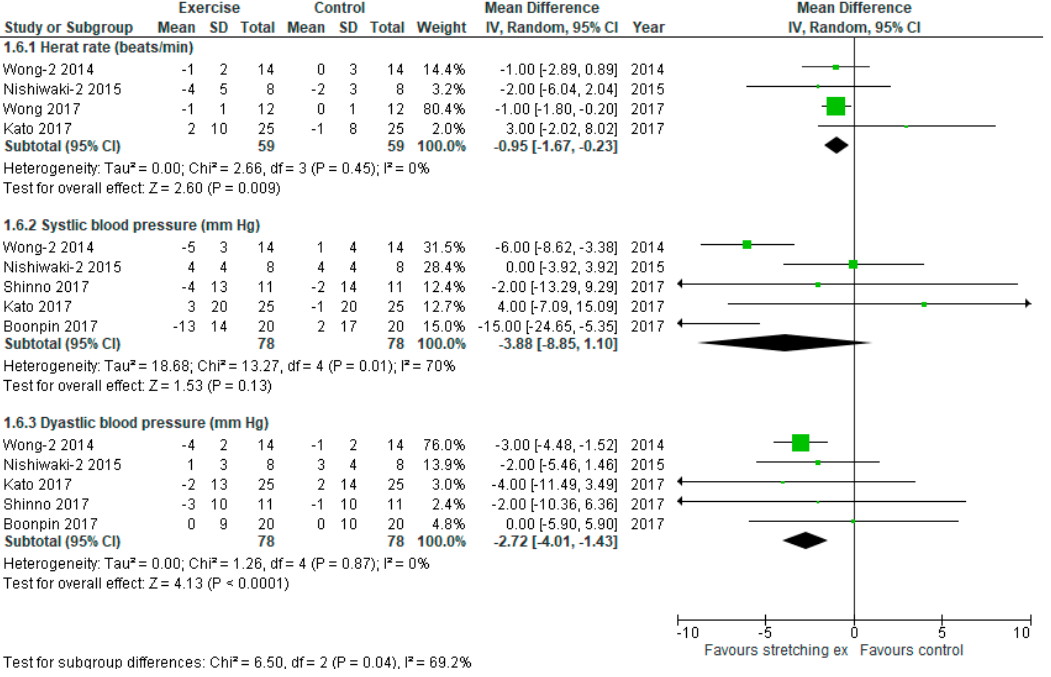
Figure 8. Forest plot comparing changes in hemodynamics following stretching exercises to non-exercise controls. SD, standard deviation; IV, inverse variance; CI, confidence interval.